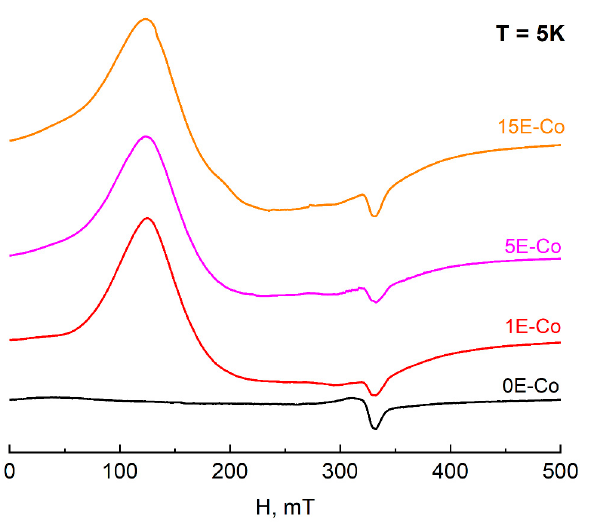
Figure 9. CW X-band EPR spectra of the aerogel samples 0E-Co , 1E-Co , 5E-Co, and 15E-Co at 5K.